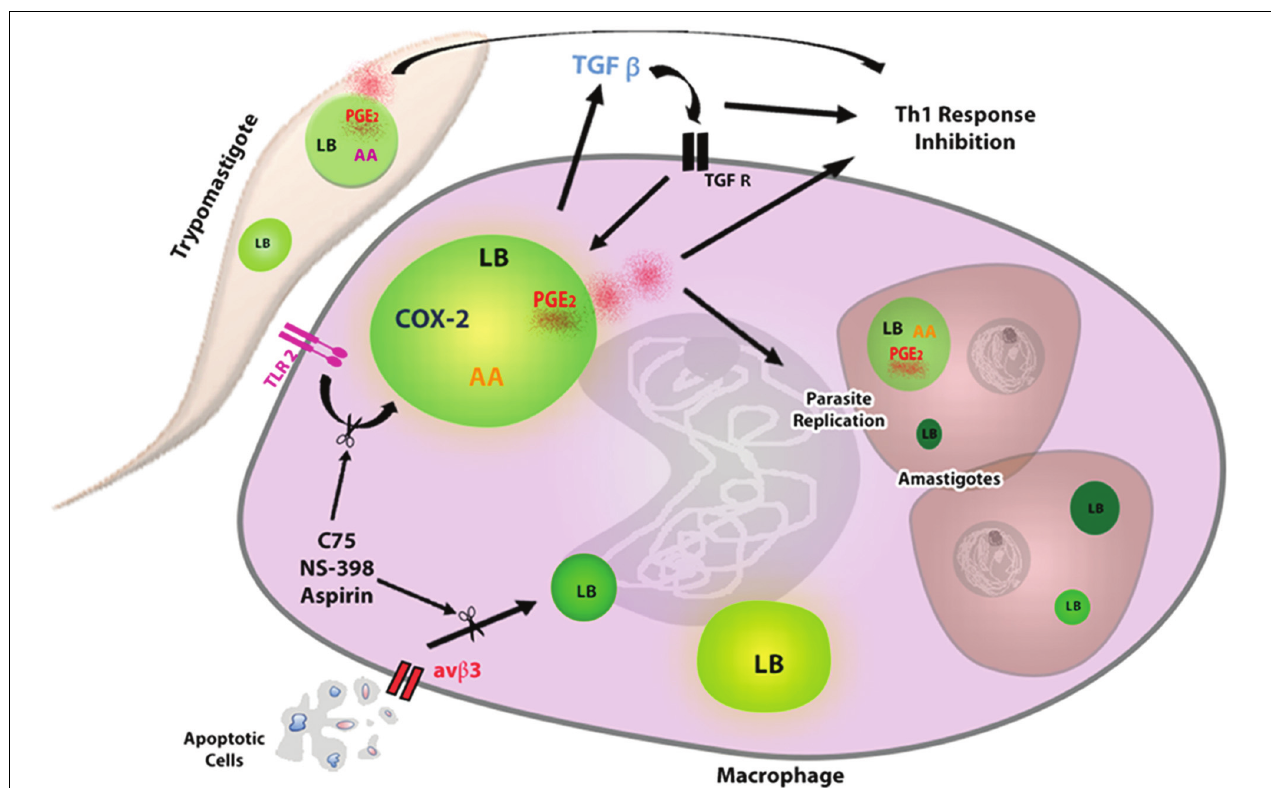
FIGURE 2 | Lipid bodies formation in response to interaction macrophage- T. cruzi favors parasite replication. The uptake of trypomastigotes through TLR2 induces LBs formation in macrophages, which is potentiated by phagocytosis of apoptotic cells through α v β 3 receptor. The interaction of parasite–macrophage also induces LBs accumulation in extracellular trypomastigotes and intracellular amastigotes, which can serve as lipid sources for parasite growth. In addition, the TGF- β produced by infected macrophages acts autocrinally contributing for LBs increase. New formed LBs from parasite and macrophage are sites for PGE 2 synthesis, because they compartmentalize the substrate (AA) and the enzymes as (COX-2 and PGE 2 synthase) for their production. PGE 2 is a potent lipid mediator that, together with TGF- β , potentially reduces the host Th1 immune response, thus decreasing the microbicidal capacity of the macrophage. The macrophages treatment with Aspirin, NS-398 or C75 can inhibit LBs accumulation and LBs-derived PGE 2 synthesis, controlling the parasite replication. AA, arachidonic acid; COX-2, cyclooxygenase -2, TGF- β R, TGF- β R